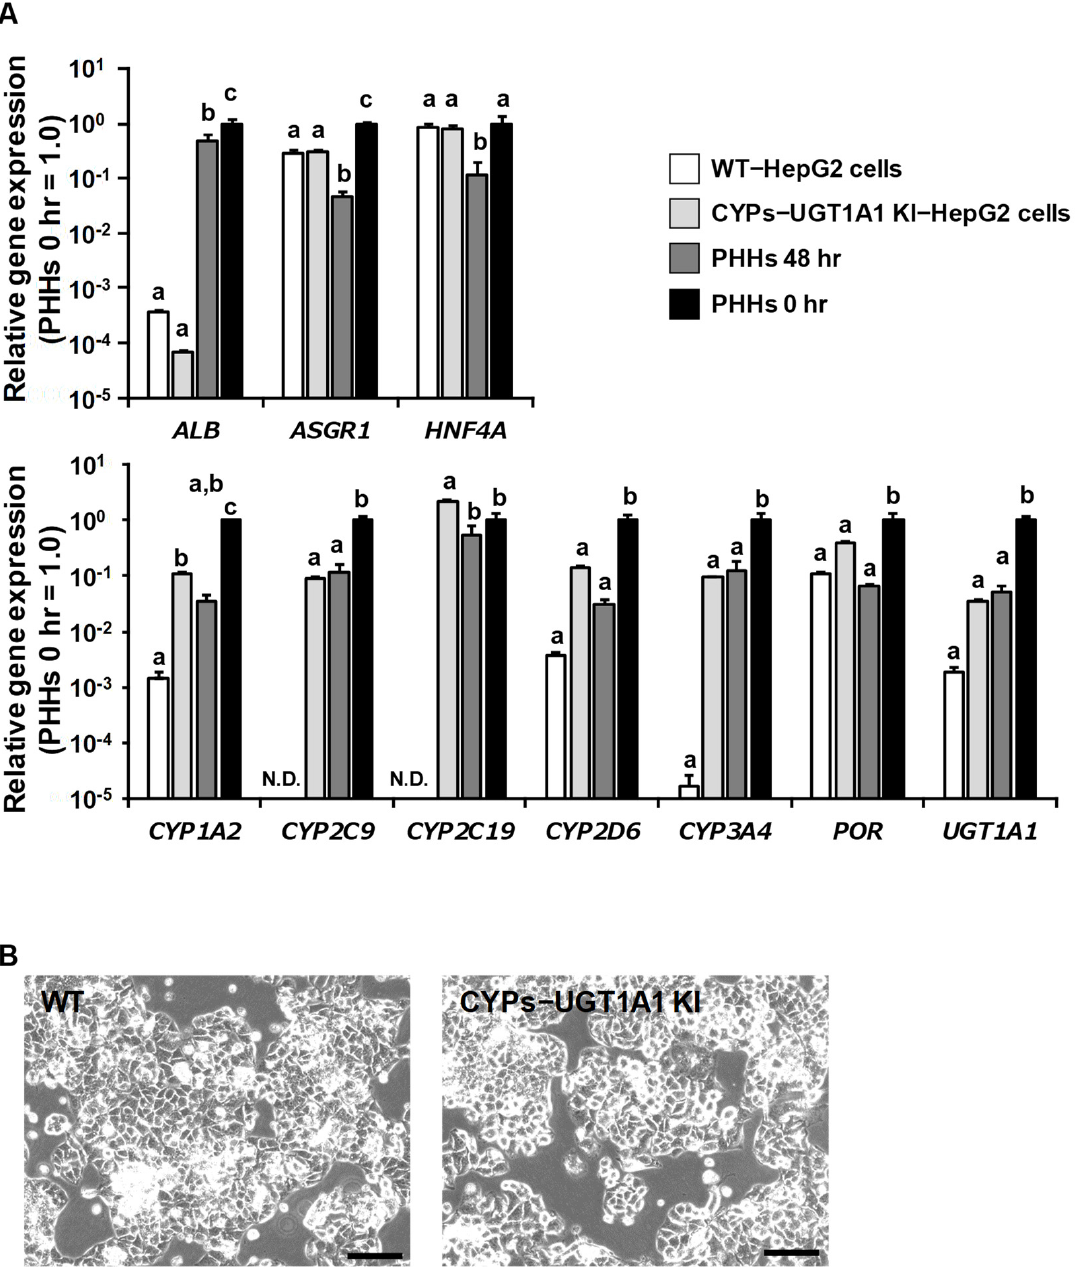
Figure 2. Expression analysis of the CYPs–UGT1A1 KI-HepG2 cells. ( A ) Real time RT-PCR was used to determine expression levels of genes for albumin (ALB) , asialoglycoprotein receptor 1 ( ASGR1 ), and hepatocyte nuclear factor 4 alpha ( HNF4A ), which served as hepatic markers, and for the drug- metabolizing enzymes cytochrome P450 family 1 subfamily A member 2 ( CYP1A2 ), cytochrome P450 fam- ily 2 subfamily C member 9 ( CYP2C9 ), cytochrome P450 family 2 subfamily C member 19 ( CYP2C19 ), cy- tochrome P450 family 2 subfamily D member 6 ( CYP2D6 ), cytochrome P450 family 3 subfamily A member 4 ( CYP3A4 ), P450 oxidoreductase ( POR ), and UDP glucuronosyltransferase family 1 member A1